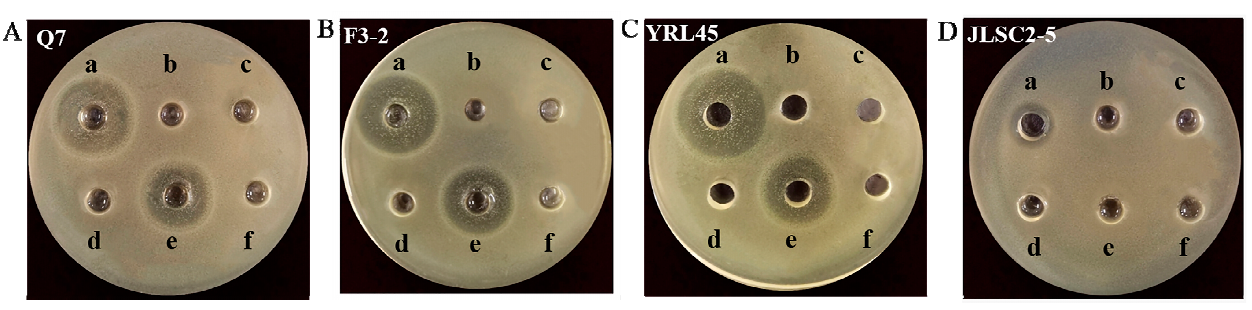
Figure 1. Effect of proteases on antibacterial activity of L. plantarum Q7 ( A ), L. plantarum F3-2 ( B ), L. plantarum YRL45 ( C ) and L. plantarum JLSC2-5 ( D ). (a) Without protease treatment. (b) Papain treatment. (c) Bromelain treatment. (d) Trypsin treatment. (e) Pepsin treatment. (f) Proteinase K treatment.